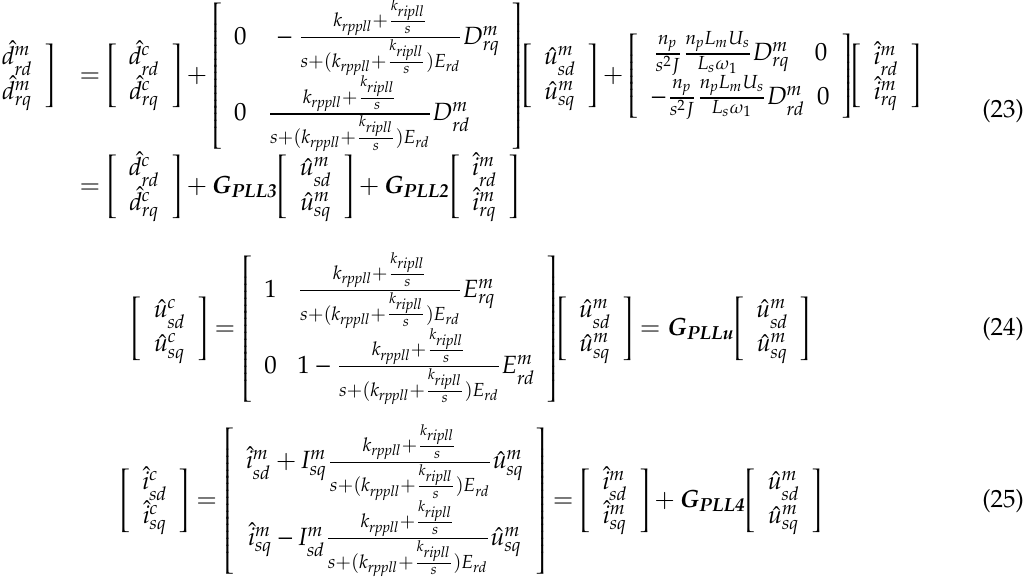
Figure 7. The angular transfer relationship between circuit module and control module on the rotor side.